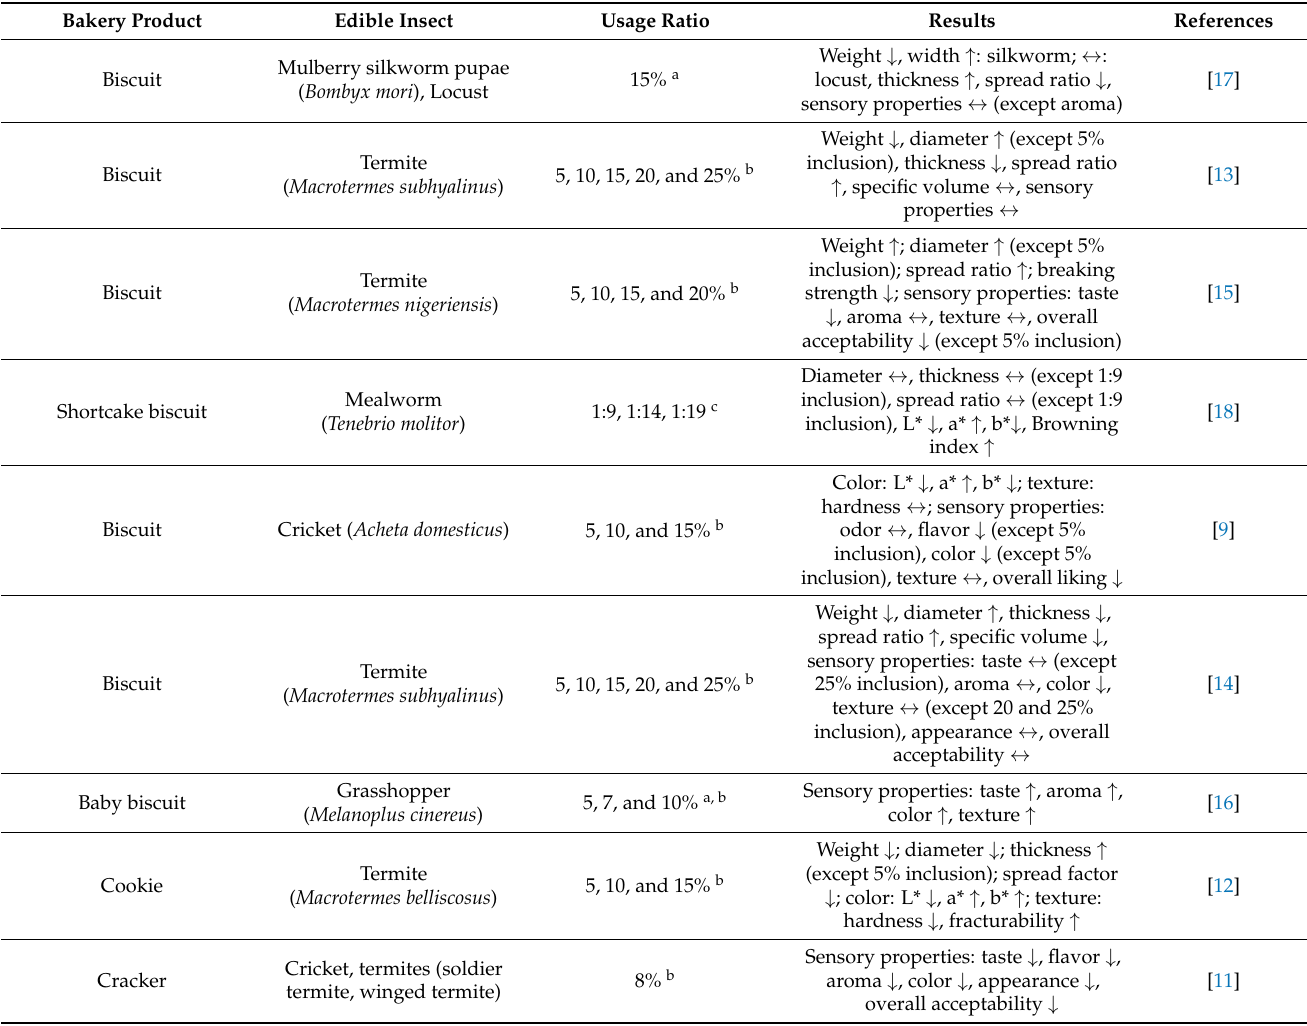
Table 1. The effects of edible insects on a number of technological and sensorial properties of some bakery